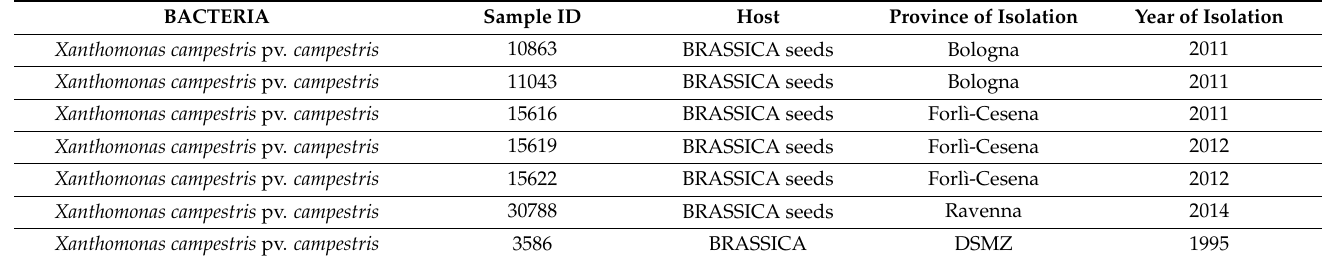
Table 1. List of Xcc bacterial